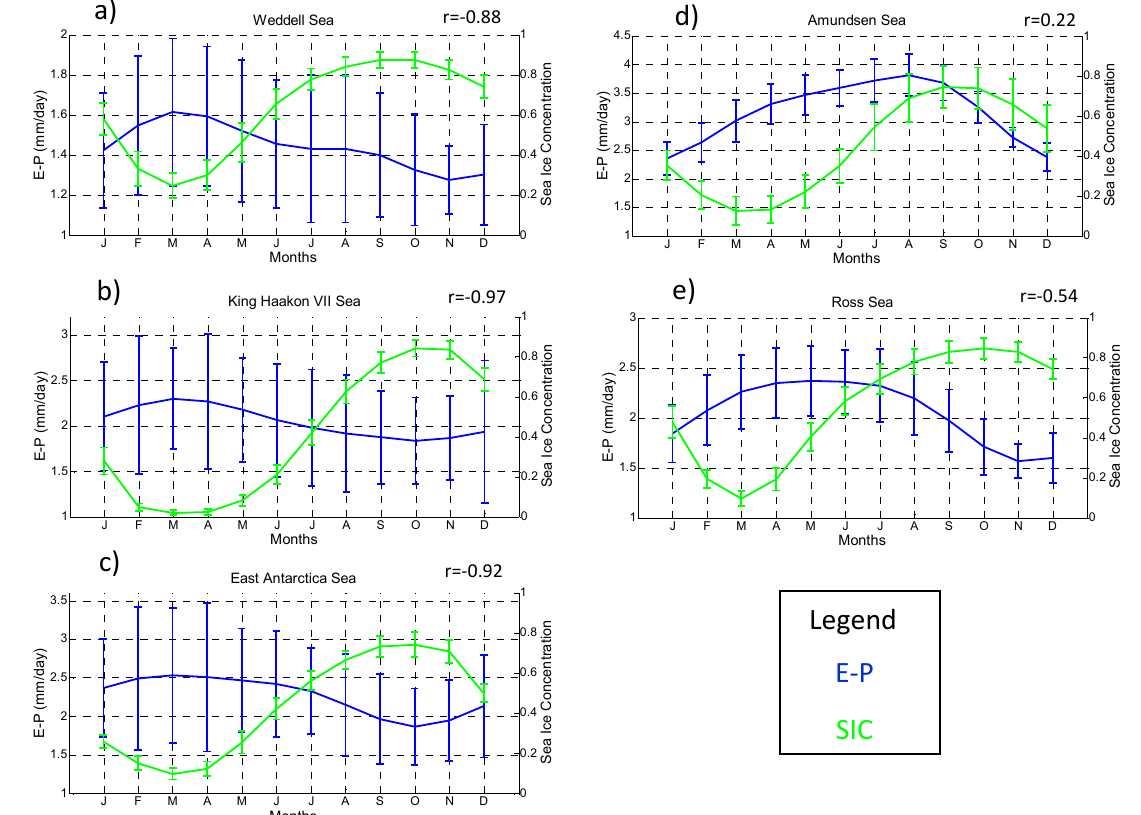
Figure 5. Annual cycle of the SIC (green line) and moisture sink (mm day − 1 multiplied by -1, blue line) in each austral sea: ( a ) Weddell, ( b ) King Haakon VII, ( c ) East Antarctica, ( d ) Amundsen, and ( e ) Ross. The error bars show the standard deviation ( σ ) of the monthly means. Table 1. Lagged correlation coefficients between the anomalous (without annual cycle) time series of the moisture sink ((E - P)i10 < 0, but multiplied by -1) for each austral sea and the SIC. For example, lag-0 (0 month lag) uses the moisture sink and the SIC from January, lag-1 (1-month lag) uses the moisture sink from January and the SIC from February, and so on. Statistically significant values (p- value < 0.05) are in bold. The strongest correlation obtained in each austral sea is highlighted in gray. Lags